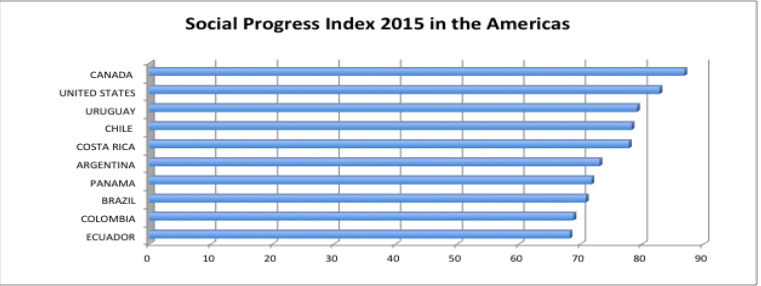
Figure 2. Social Progress Index in the Americas in 2015; amended from Porter et al. (2015) 1 . Except for some countries (e.g., Uruguay and Chile), the SPI and GCI confirm an old view: “ . . . Latin America is, after all, the only part of the world which is both Christian and underdeveloped” (Levine 1981, p. 35). The next section addresses the prosperity-religion nexus as a feature that help to better explain the imbalanced SPI and GCI differences among countries.